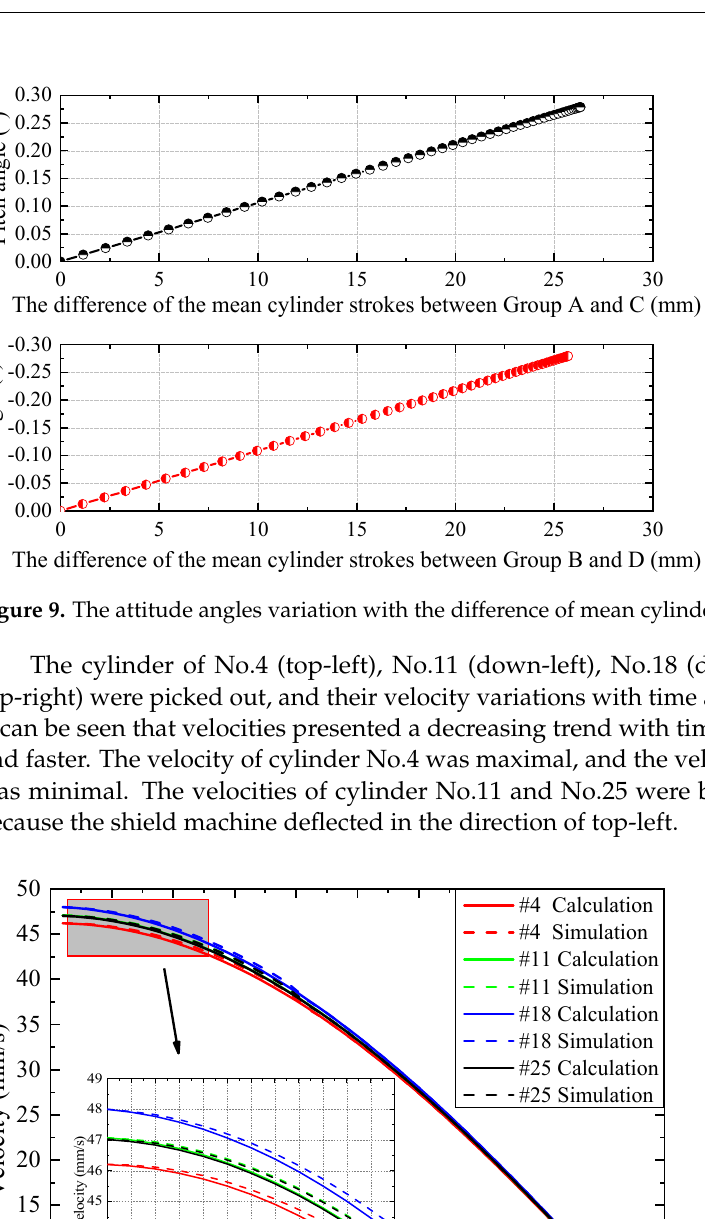
Figure 10. Velocity–time diagram of different cylinders.